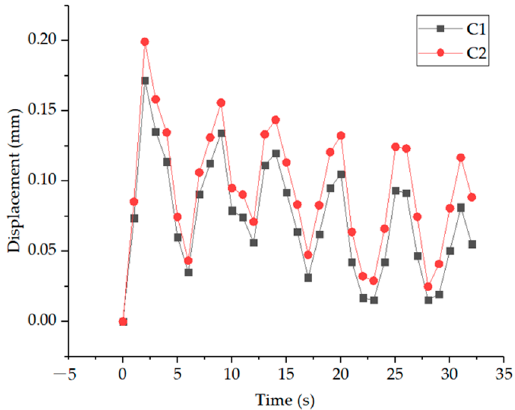
Figure 16. Curve of time and displacement.